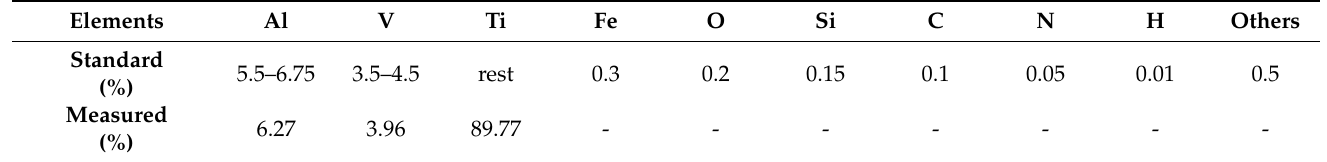
Table 1. Composition of